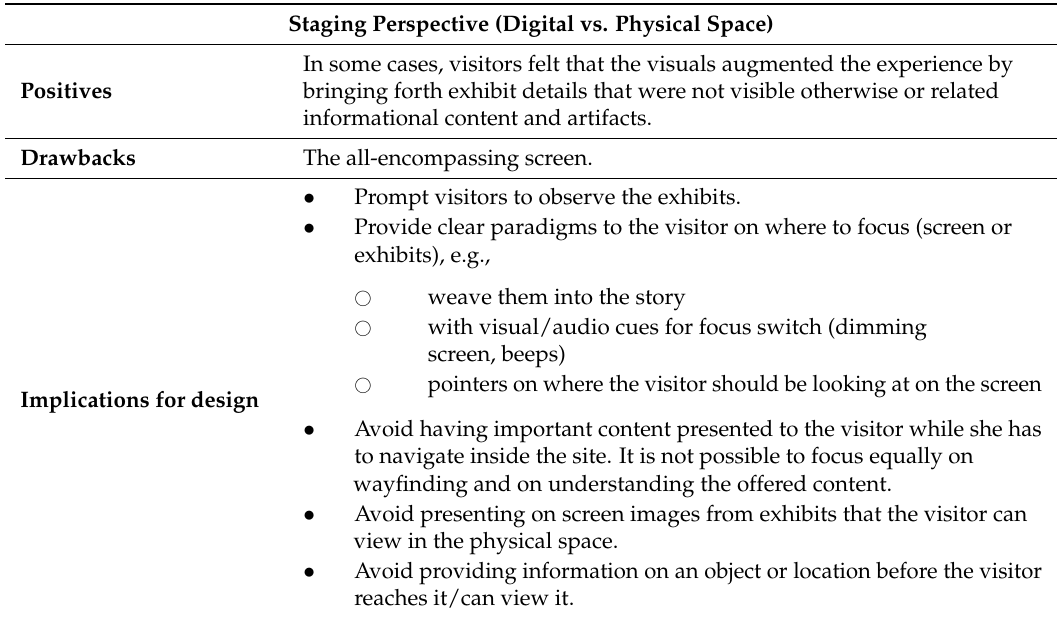
Table 4. Insights from findings on the staging perspective, and implications for